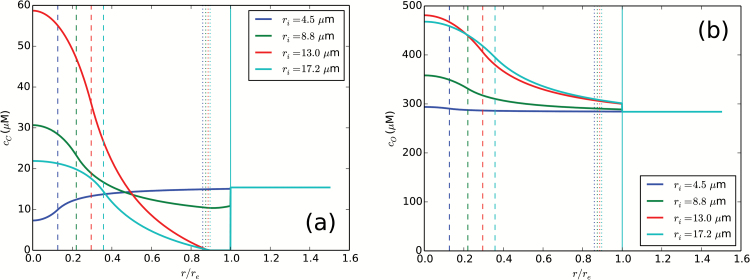
CO2 and O2 concentration profiles. Radial profiles of carbon dioxide (a) and oxygen (b) concentration for a fixed periphery to core distance, rv–ri=26 μm, and varying core radii, ri. Selected radii correspond to the C3 region (ri=4.5 μm, blue), finite PEPC region (ri=8.5 μm, green), and abundant PEPC (ri=12.5 μm, 16.5 μm, red and light-blue respectively). Distances are scaled by the cell radius, re. The dashed, dotted, and full vertical lines mark the ri, rv, and re radii. Parameters are as Fig. 2.